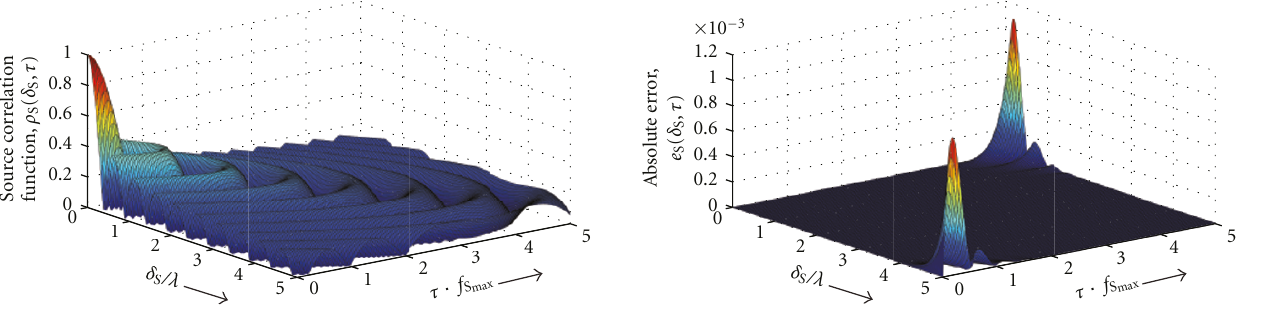
Figure 5: Absolute error e S ( δ S , τ ) = | ρ S ( δ S , τ ) − (cid:22) ρ S ( δ S , τ ) | by using the MMEA with M = 40 (isotropic scattering).